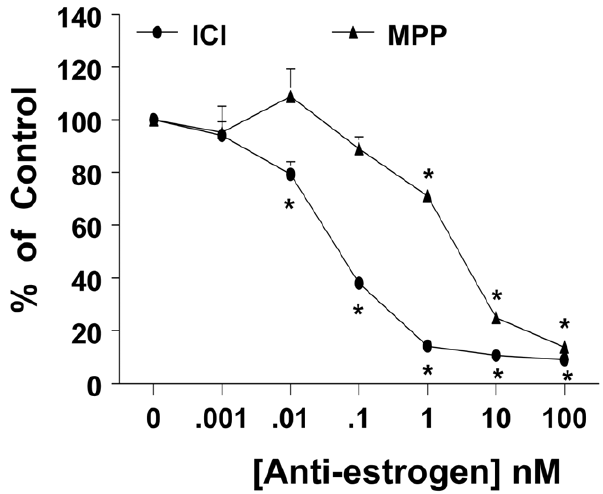
Figure 4. MPP and ICI 182780 inhibit ERE transcriptional activity. GH3 cells, transiently co-transfected with an ERE reporter gene and a control reporter gene, were treated with the indicated concentrations of ICI or MPP for 24 hrs, and normalized luciferase activity was determined as described in methods. Data was calculated as % of vehicle control (100%). Each value is the mean 6 SEM of 4 separate experiments each performed in triplicates. * indicates significant difference from control ( p , 0.05